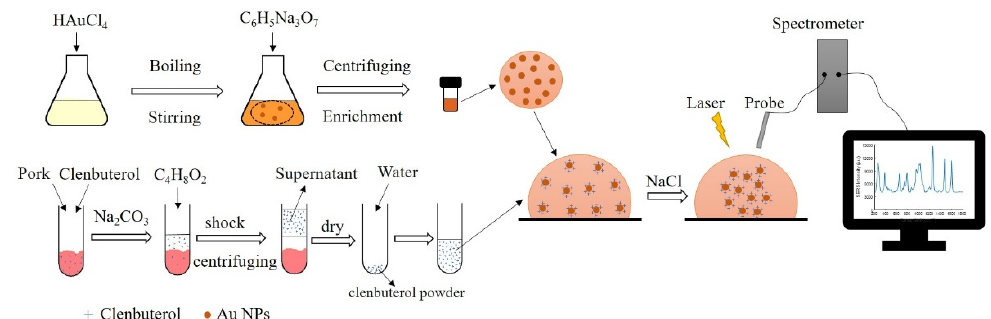
Figure 1. Schematic illustration of preparation and clenbuterol detection process of gold colloid.